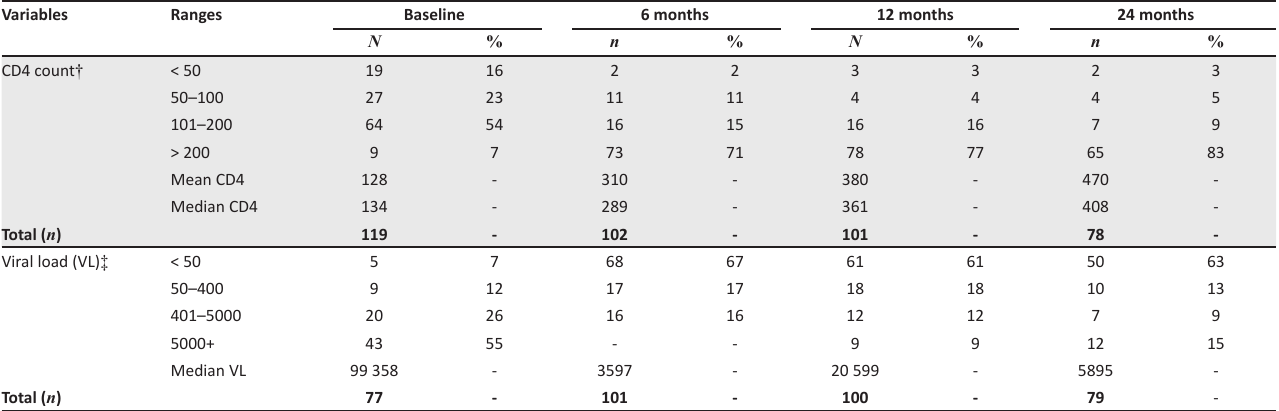
TABLE 3: CD4 counts and viral loads.